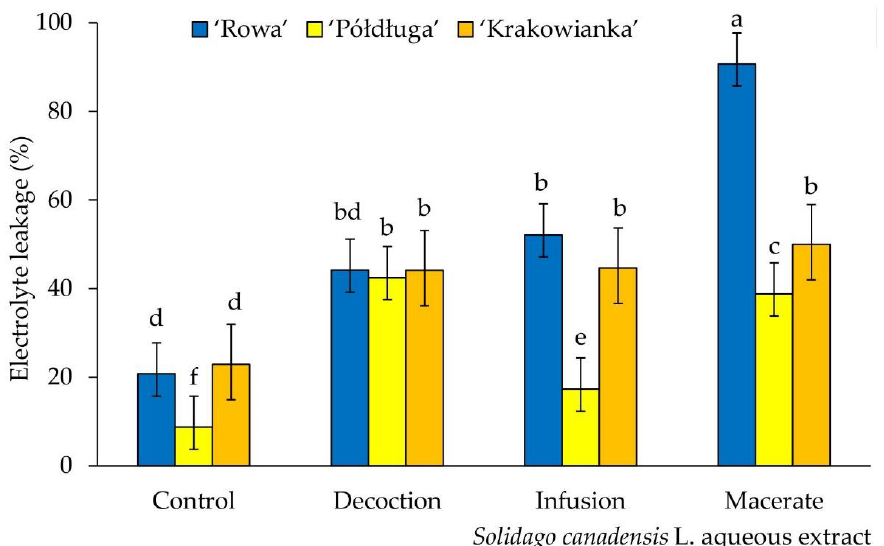
Figure 3. Electrolyte leakage of three cultivars (‘Rowa‘, ‘Półdługa‘, ‘Krakowianka‘) of radish seeds ( Raphanus sativus L.) treatment of aqueous extracts from Solidago canadensis L. leaves; mean values ± SD ( n = 10) with different letter (a–f) differ statistically according to Duncan test at p < 0.05.